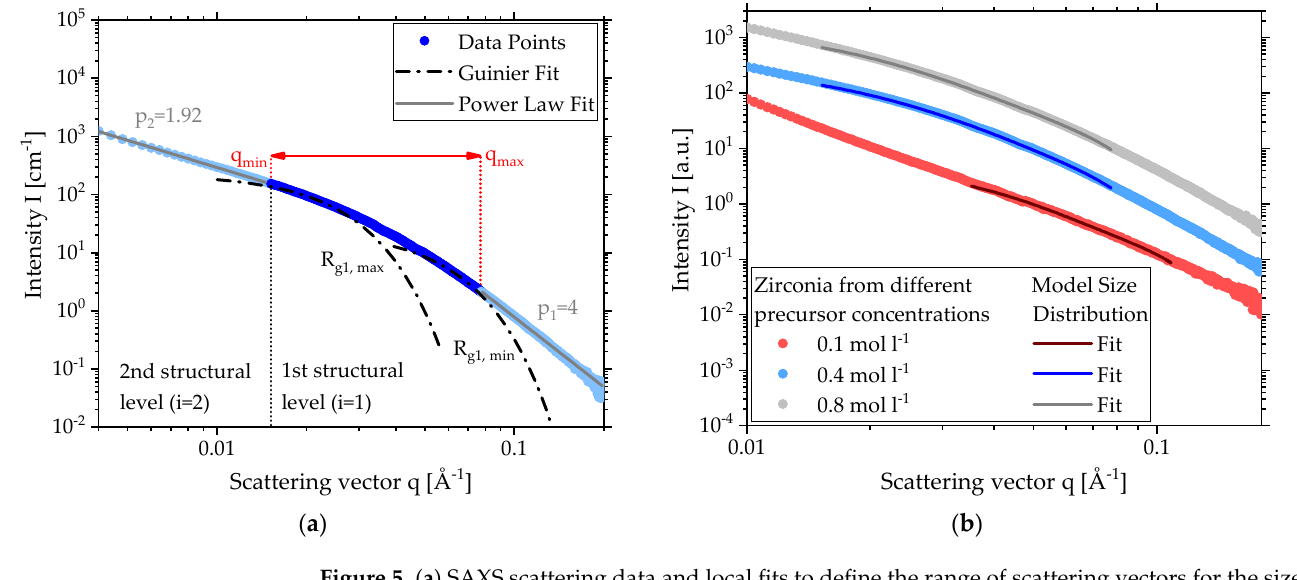
Figure 5. ( a ) SAXS scattering data and local fits to define the range of scattering vectors for the size distribution fit for zirconia made by SFS with c = 0.4 mol L − 1 . ( b ) SAXS scattering data for zirconia made by SFS with different precursor concentrations and the fits of the Model Size Distribution ( c = 0.1 mol L − 1 , c = 0.4 mol L − 1 , c = 0.8 mol L − 1 Table 1. Range of scattering vectors for the size distribution fit as well as the slope p 1 of the 1st power law fit.